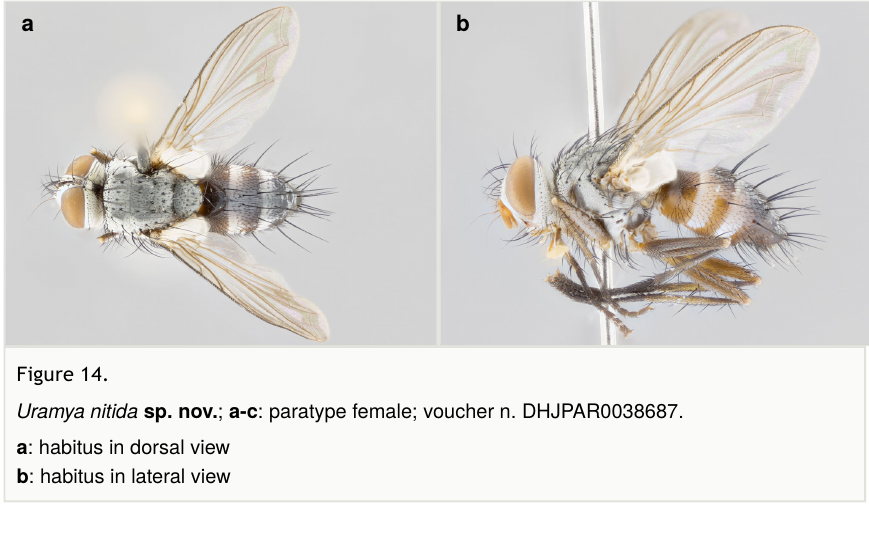
Figure 14. Uramya nitida sp. nov. ; a-c : paratype female; voucher n.